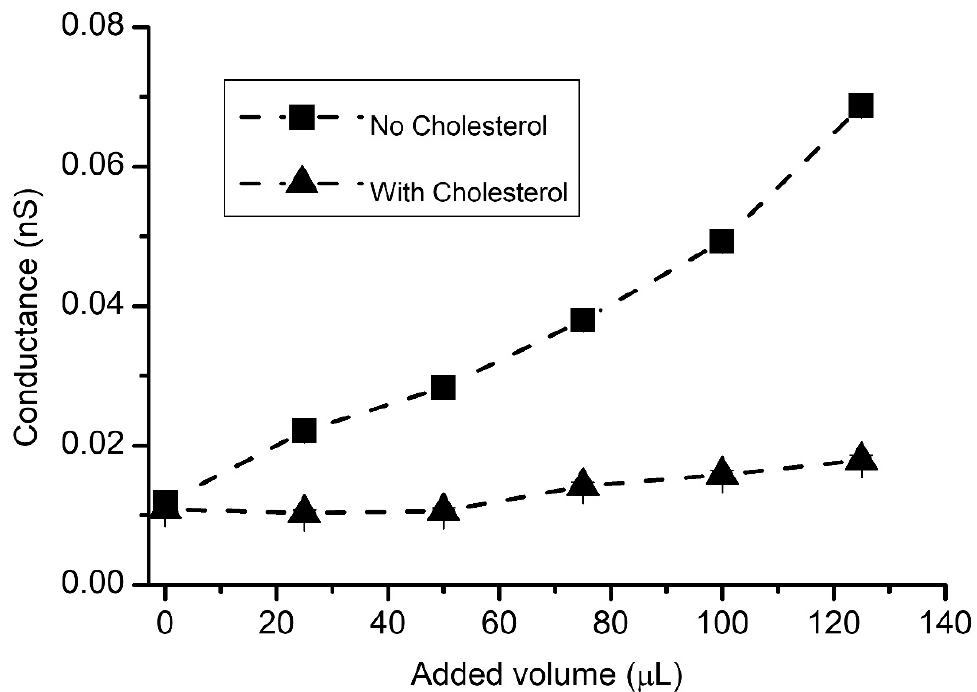
Figure 7. Cholesterol modulates the changes in membrane’s conductance in response to hydrostatic pressure created by solution additions. The conductance varies differently for membranes without cholesterol (squares) and with cholesterol (up triangles). The average conductance values were calculated from three different runs of the same experiments.